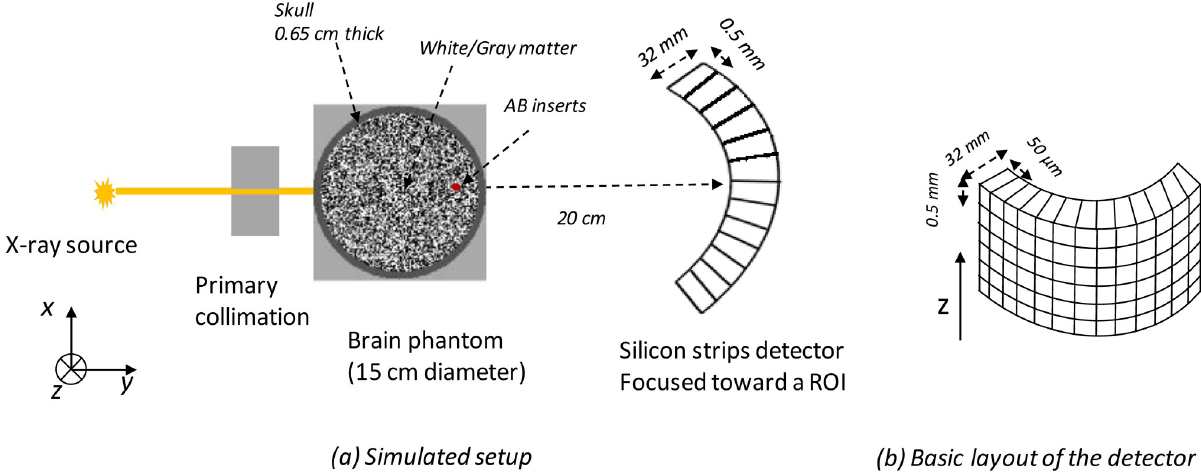
Fig 1. Schematic representation of the coherent scatter system combining energy-resolved information at multiple scattering angles with a polychromatic pencil beam and an energy-resolved detector.